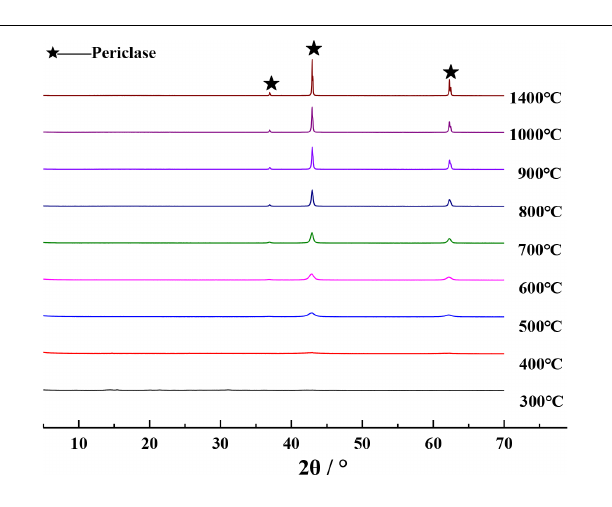
when Mg(OH) 2 · 3MgCO 3 · 3H 2 O or Mg(OH) 2 was calcined at